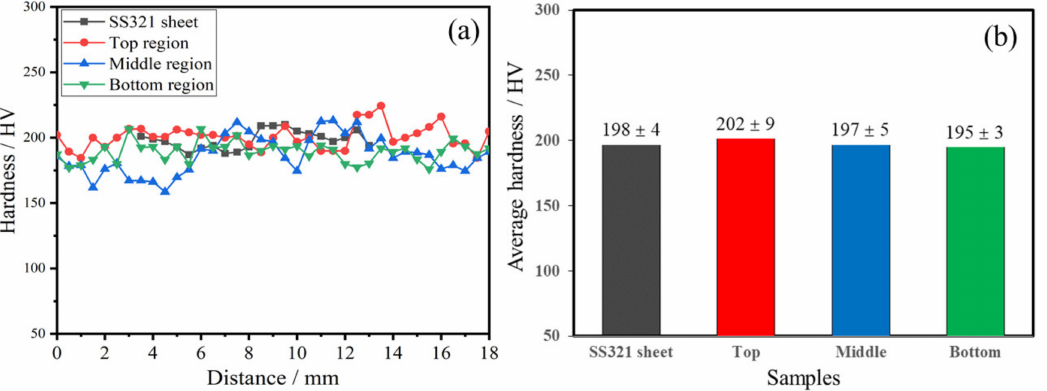
Figure 5. Curves of hardness ( a ) and average hardness ( b ) of SS 321 sheet, the top region, middle region, and bottom region of the SS 321